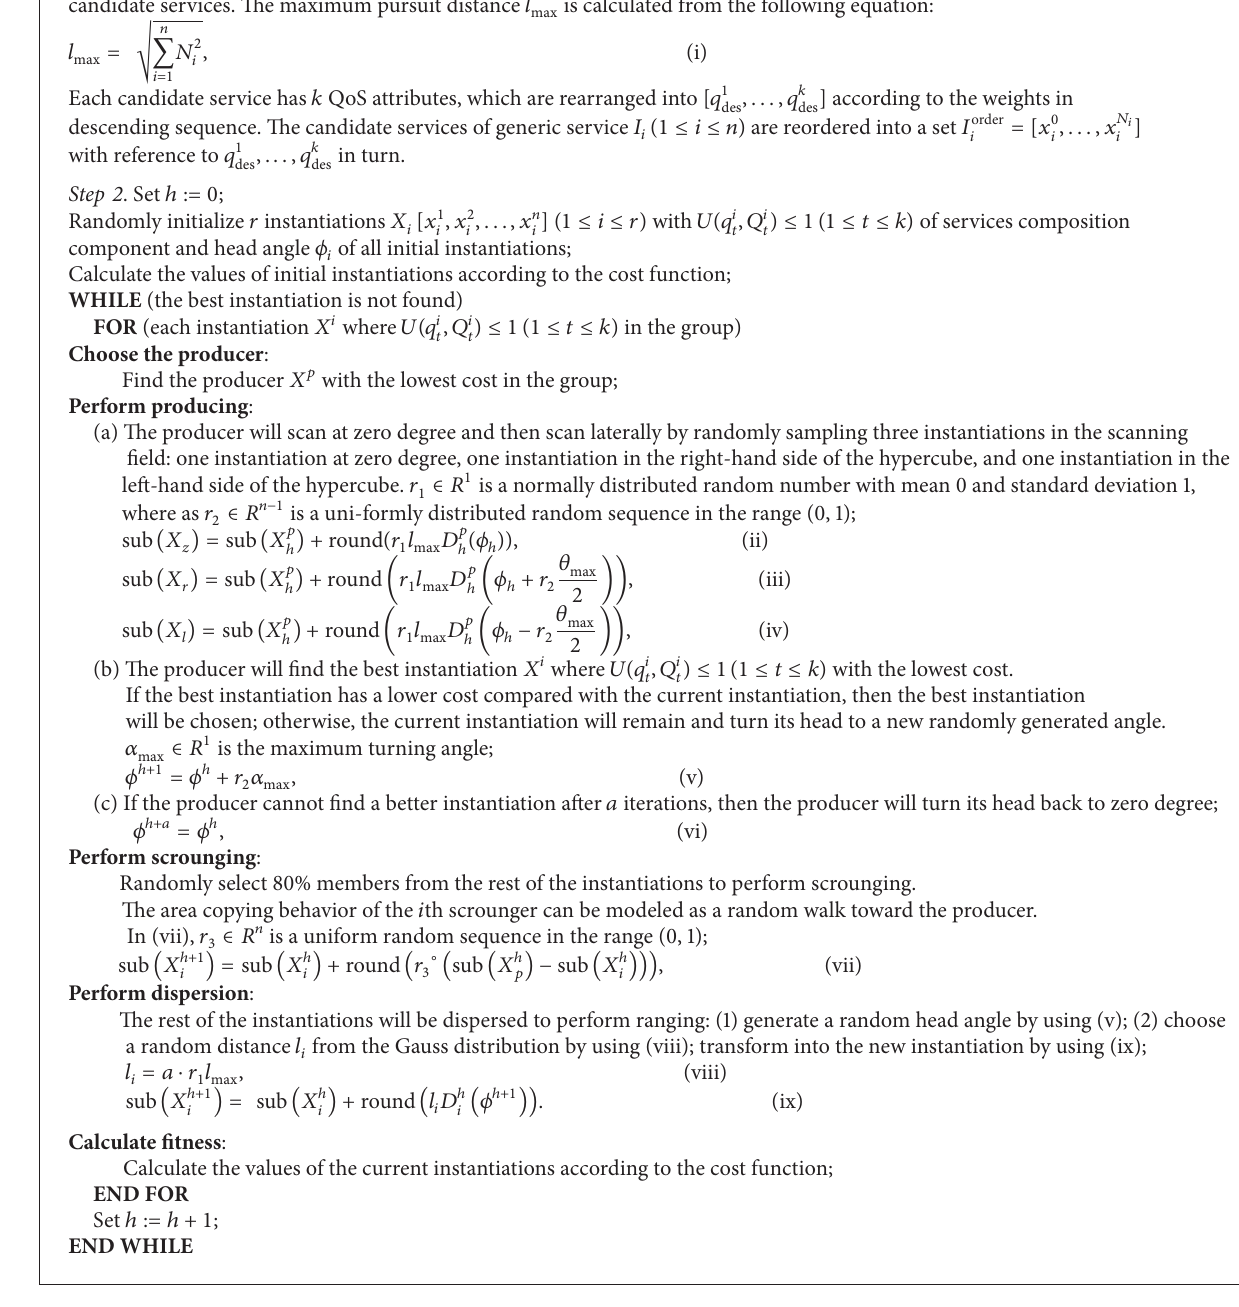
Algorithm 1: Procedure for the D-GSO